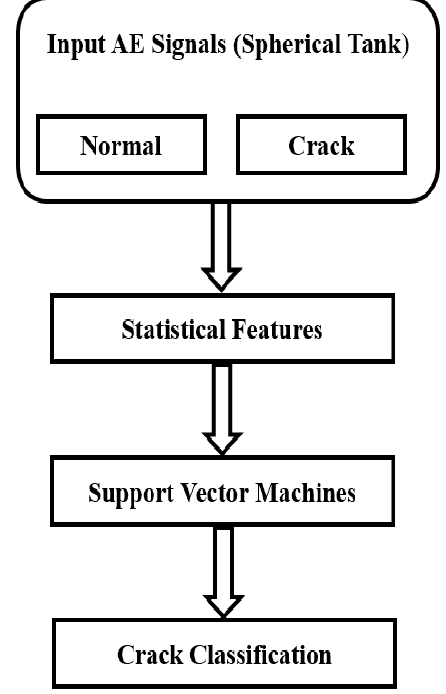
Figure 1. The proposed spherical tank crack-detection model. AE: acoustic emissions.